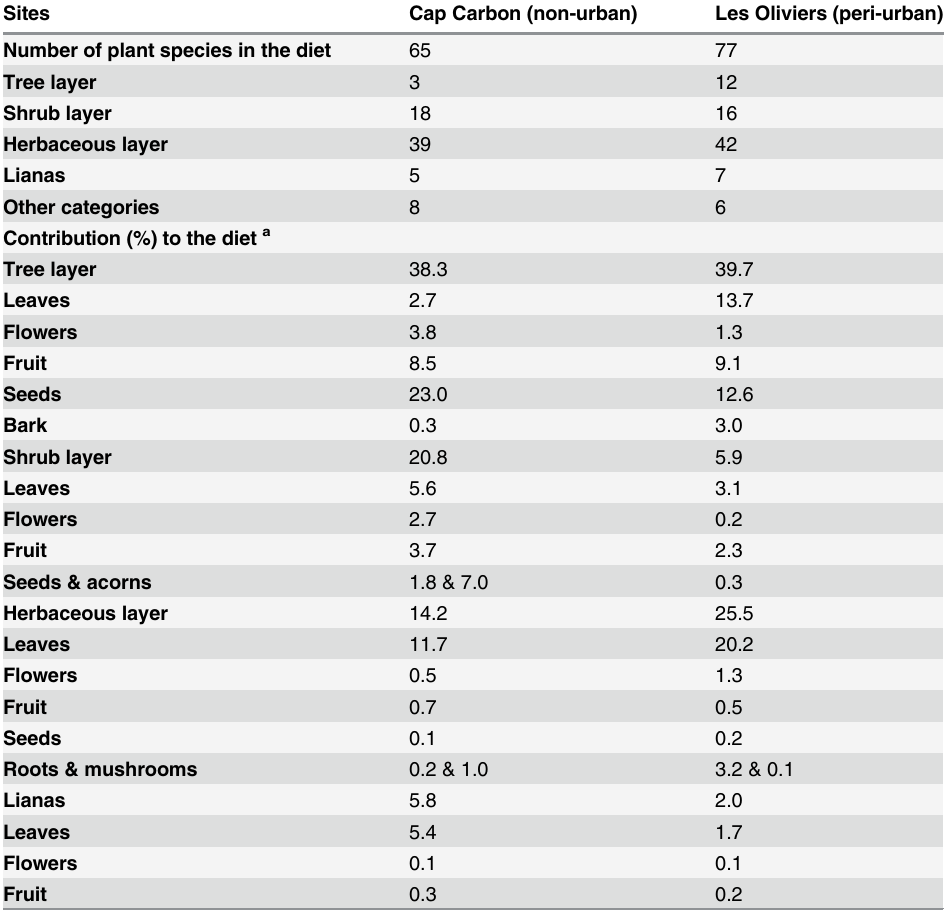
Table 1. Number of plant species in the macaques ’ diet and contribution (%) of each vegetation layer to the diet at each site.